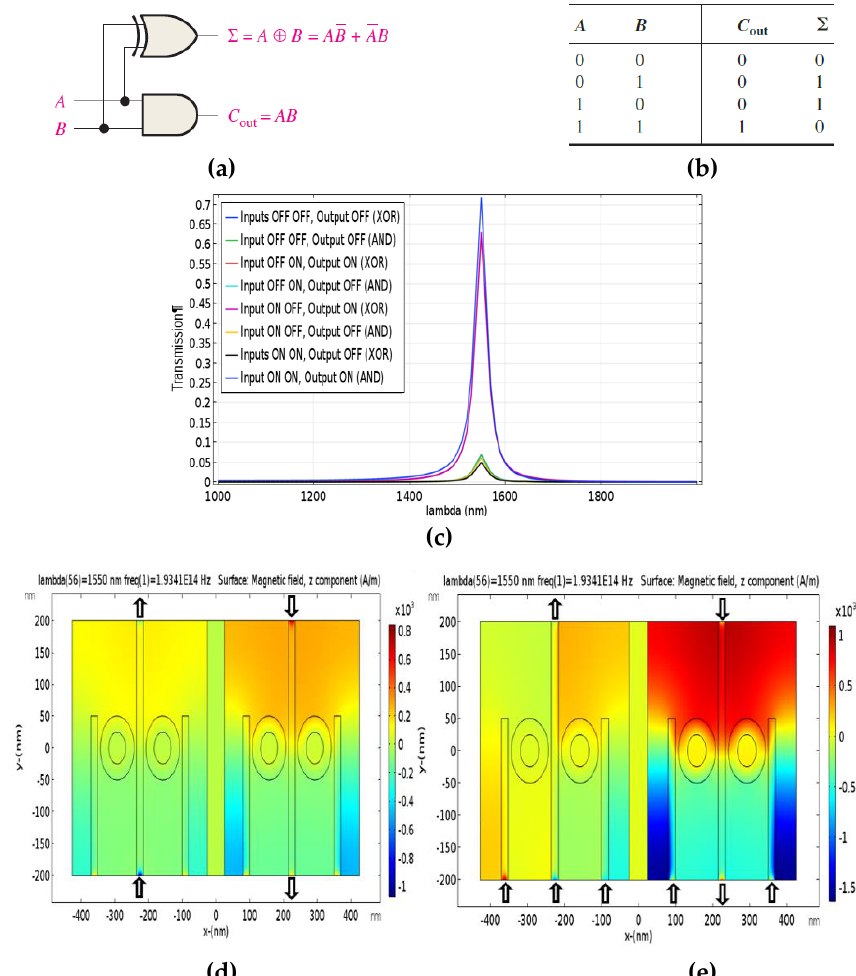
Figure 2. ( a ) and ( b ) the conventional half-adder logic diagram and its truth table, respectively. ( c ) The transmission spectrum of the proposed plasmonic half-adder for different states, according to its truth table. ( d ) and ( e ) the magnetic field distribution of Logic 00 and Logic 11 inputs, respectively.